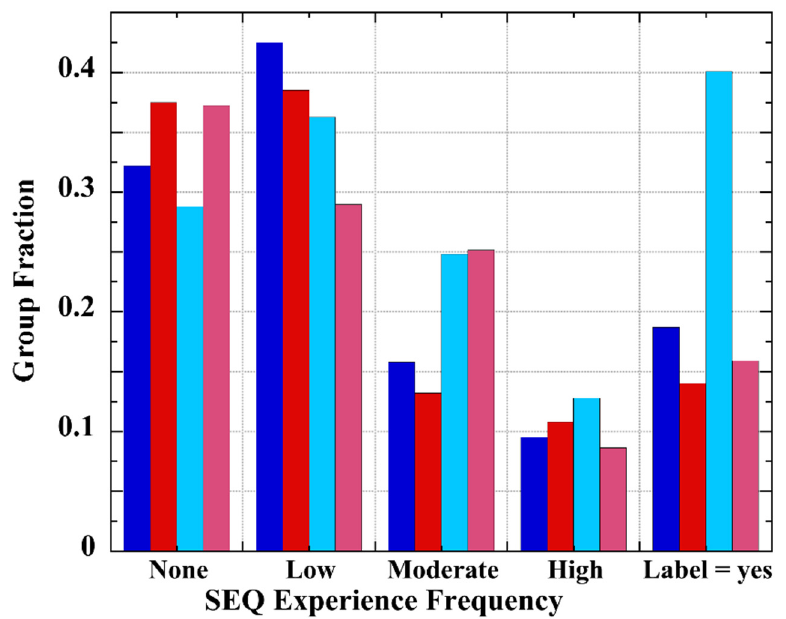
Figure 4. Group fractions from two studies of female agribusiness employees (Sample 1) or academic faculty and staff (Sample 2) partitioned into low, moderate, and high frequencies of SEQ experiences or, at the far right, those who labeled their SEQ experiences as sexual harassment. Sample 1 or Sample 2, respectively: Schneider et al., 1997 [12], dark blue or dark red; Magley et al., 1999 [16], light blue or pink. In each case, the respective samples were composed of identical study groups and identical SEQ responses, which were segregated using equivalent numerical methods. The only analytical difference was the manner in which the researchers chose to divide the cohorts into low, moderate, and high harassment groups.